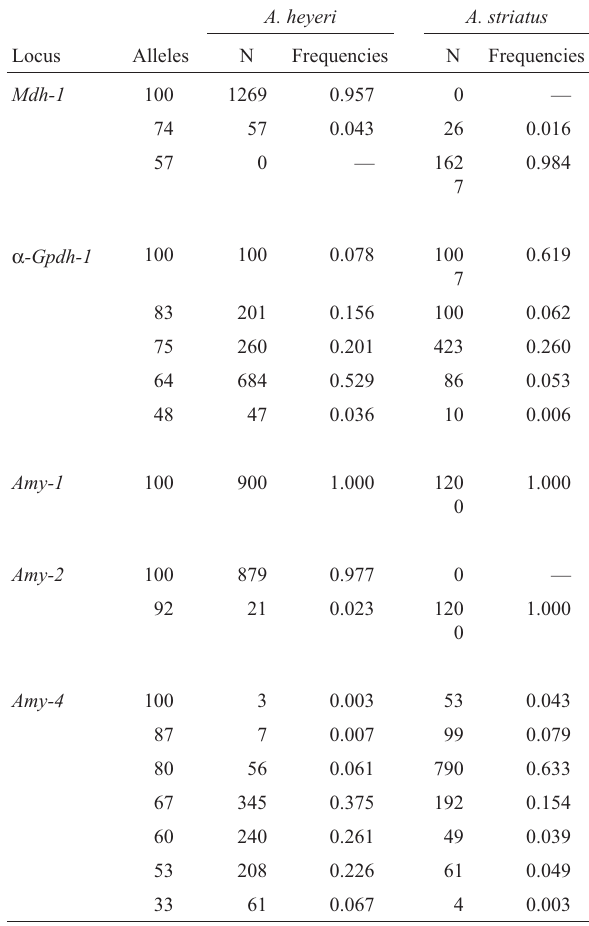
TableI -Allelicfrequenciesoffiveisoenzymelocioftheleaf-cuttingants Acromyrmex heyeri and Acromyrmex striatus